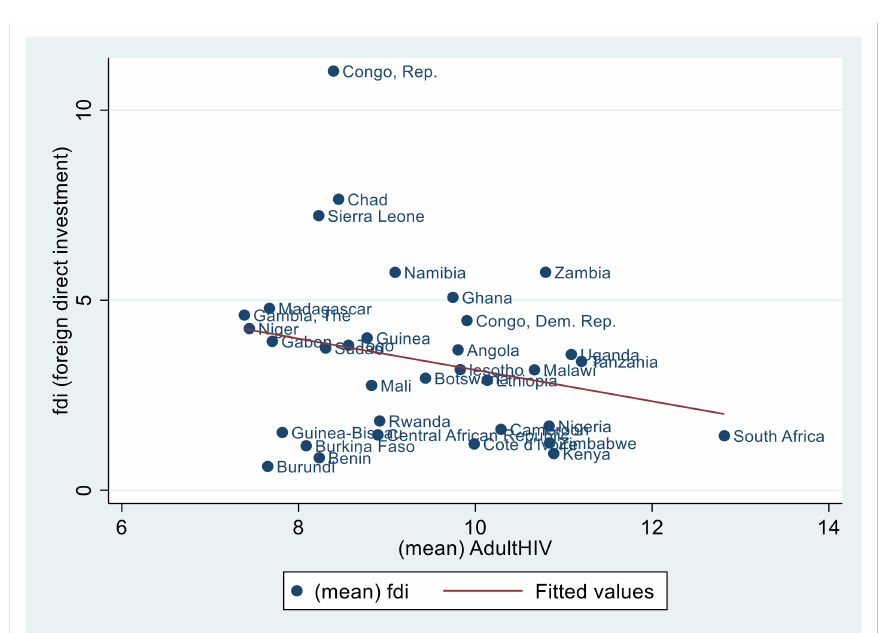
Figure 6. HIV prevalence and FDI.